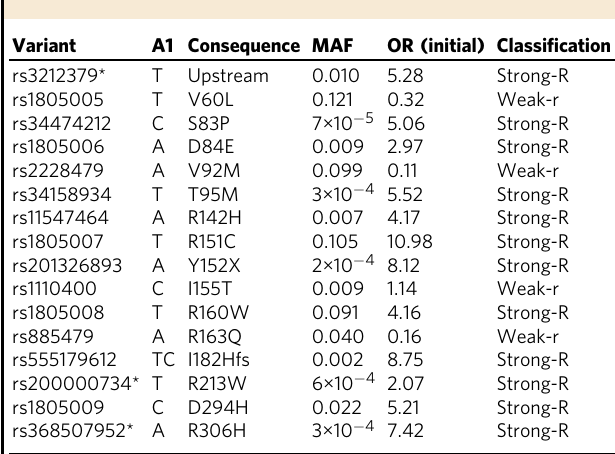
Table 2 MC1R variants